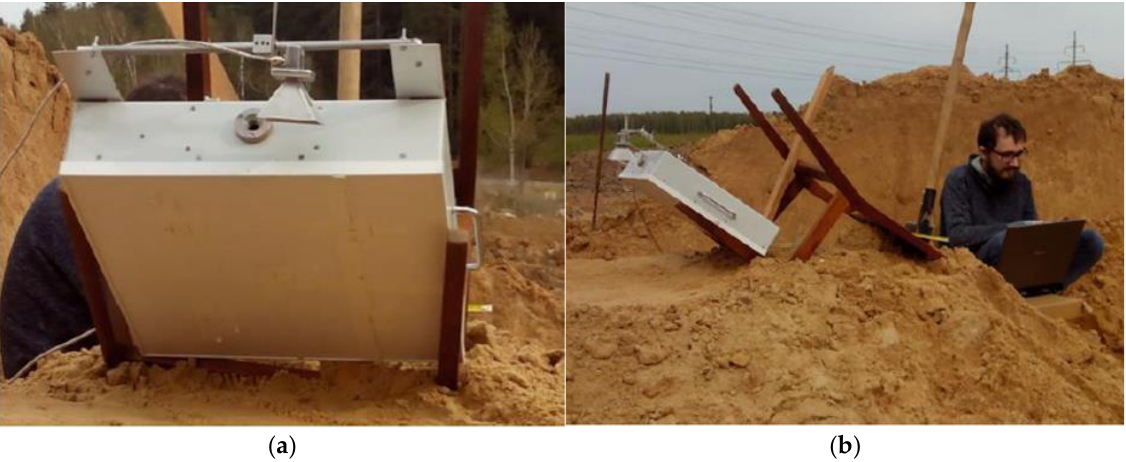
Figure 23. Photo of the HSR prototype with a movable radiator ( a ). Preparing experimental site and equipment ( b ).